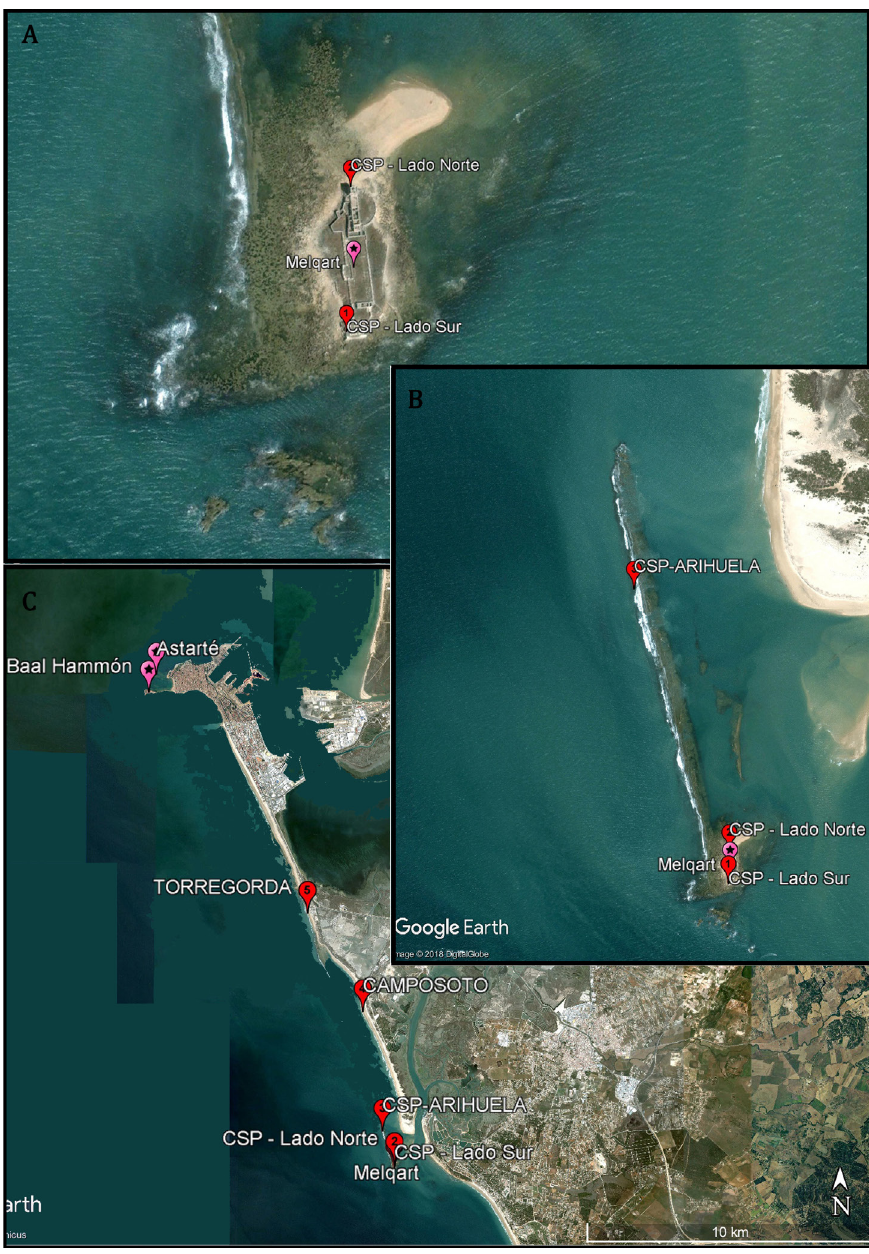
Figure 7. Spatial markers of the five points of the experimental visibility study of the shrine of Melqart. A. Situation of point 1 (CSP-South Side), point 2 (CSP-North Side) and the shrine itself. B. Markers of the three points closest to Sancti Petri Castle: CSP-South Side, CSP-North Side, CSP-Arihuela (point 3). C. Position of the five reference sites used in the study: point 1 (CSP- South Side), point 2 (CSP-North Side), point 3 (CSP-Arihuela), point 4 (Camposoto) and point 5 (Torregorda) (Source: Google Earth. Own